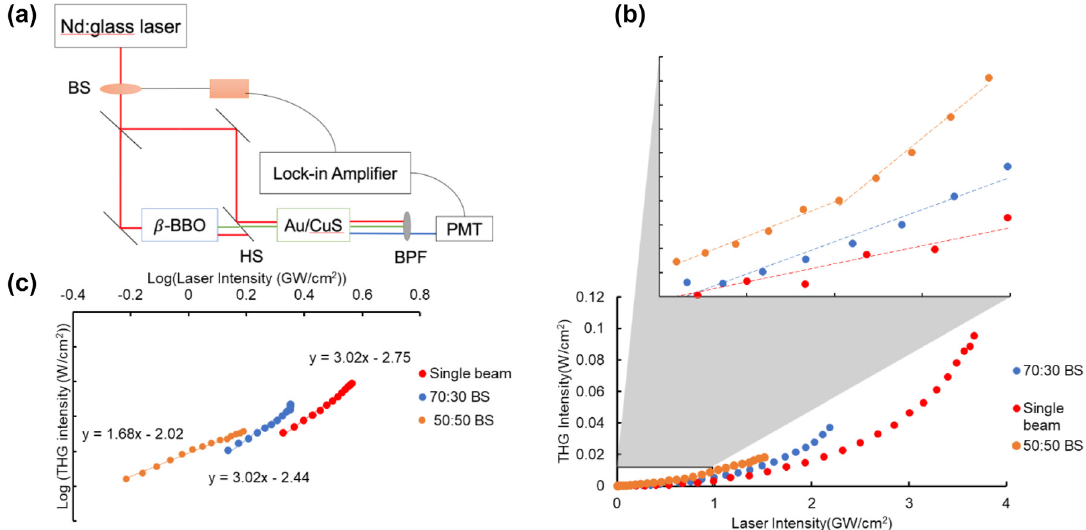
Figure 3: Sum frequency generation from Au/CuS bilayer films by dual-beam pumping. (a) A simplified diagram of the experimental dual-beam setup. BS, beam splitter; HS, harmonic separator, BPF = 350 nm bandpass filter. Red line is 1050 nm fundamental beam, green is 525 nm (2 𝜔 ) beam, and blue 350 nm (3 𝜔 ) beam. (b) Intensity of THG output generated by hybrid films as a function of fundamental beam intensity after beam splitter for different R : T ratio beam splitter: 100:0 (red—power of 2 𝜔 0 μ W), 70:30 (blue—power of 2 𝜔 beam 185 μ W), 50:50 (orange—power of 2 𝜔 300 μ W). (c) Double-logarithmic plots of THG intensity as a function of pump laser intensity for the data of